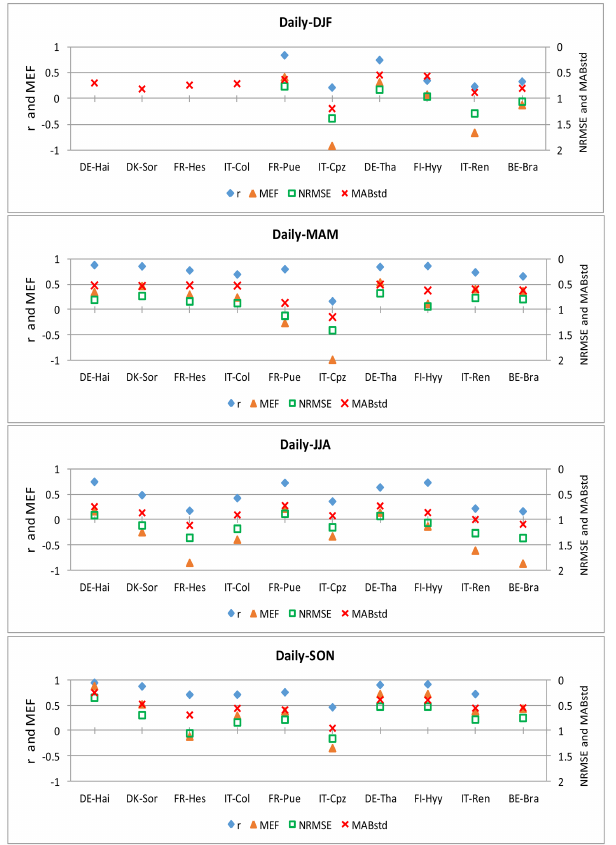
Figure 5. 3D-CMCC FEM performance indices of daily GPP ag- gregated to months at different seasons. DE-Tha refers to the 1S simulation, IT-Ren to the 2L_2C simulation, BE-Bra to the P_Q-3L simulation (see